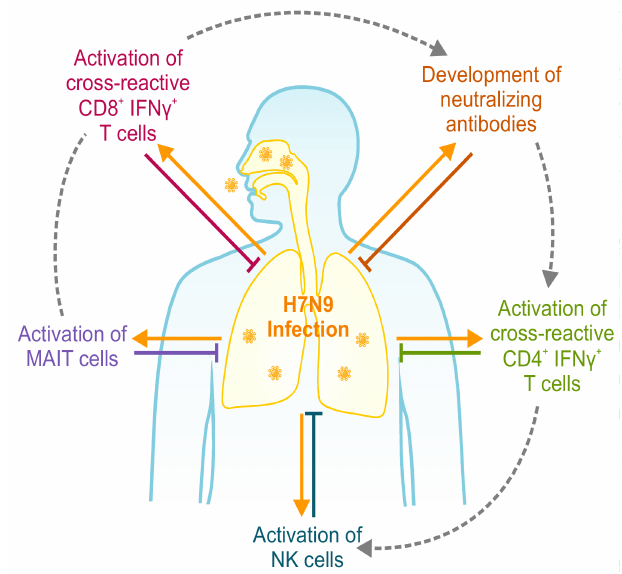
Figure 1. CD4 and CD8 T cells act in synergy with multiple immune arms for heterologous protection. Effective heterologous immunity against zoonotic influenza (H7N9) viruses requires synergy of multiple immune arms [30,76,78]. Without the recruitment of two or more immune arms, protective immunity is diminished, as modelled on outcomes of infection from H7N9-infected patients. Although multiple arms are likely to be activated at the same time, hospitalized patients clearly demonstrate that different arms had a more prominent role if one arm fails to respond. MAIT: mucosal associated invariant